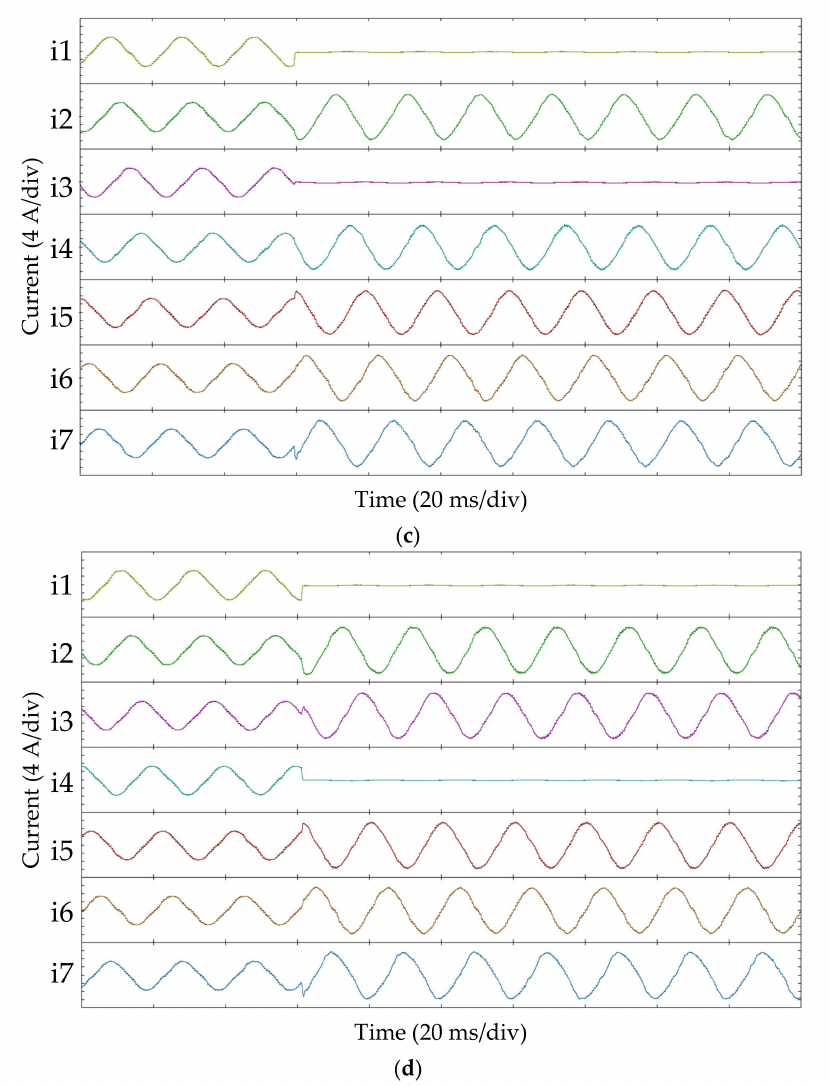
Figure 14. Seven-phase currents of experimental performance at 1500 rpm speed and 10 Nm load condition (20 ms/div). ( a ) Fault 1, ( b ) Fault 2, ( c ) Fault 3 and ( d ) Fault